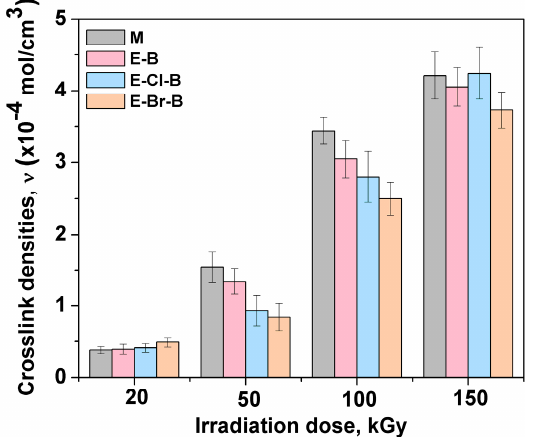
Figure 9. Variation of crosslink density with irradiation dose.